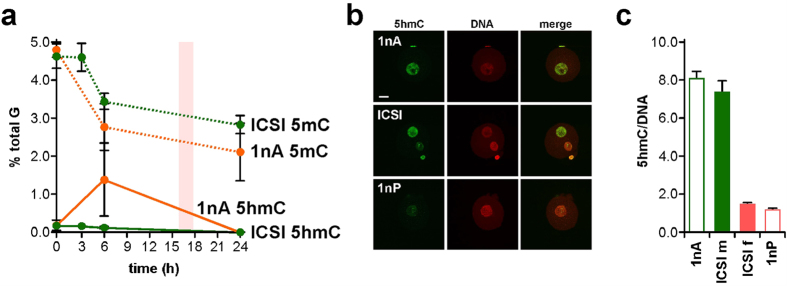
Comparative 5 mC and 5 hmC profiles for ICSI and androgenesis.(a) Levels of 5 mC (dotted lines) and 5 hmC (solid lines) determined by SMM and expressed as a percentage of total G-residues in embryos at the times shown (h) after activation. A value of 0.00 was taken for samples in which 5 hmC was not detected. Embryos were generated by intracytoplasmic sperm injection (ICSI, green) or androgenesis (1nA, orange). Data (2 ≤ n ≤ 3) are expressed as means (±sd). Zero hour time points show the average of combined values for sperm plus mII oocyte (ICSI) or sperm alone (1nA). (b) Fluorescence images of a haploid androgenote (1nA, top row), an embryo generated by ICSI (central row) and a haploid parthenogenote (1nA) 6 h after sperm injection (1nP and ICSI) or parthenogenic activation (1nP). Embryos were labeled with anti-5 hmC antibodies (green) and propidium iodide (DNA, red). Scale bar, 10 μm. (c) Pixel quantification (± s.e.m.) of n = 5 samples of (b), showing fluorescence levels normalized against PI (DNA). For paternal pronuclei in 1nA and ICSI (ICSI m), and maternal pronuclei in 1nP and ICSI (ICSI f), p > 0.05. Embryo numbers per analysis are given in Supplementary Table S1.